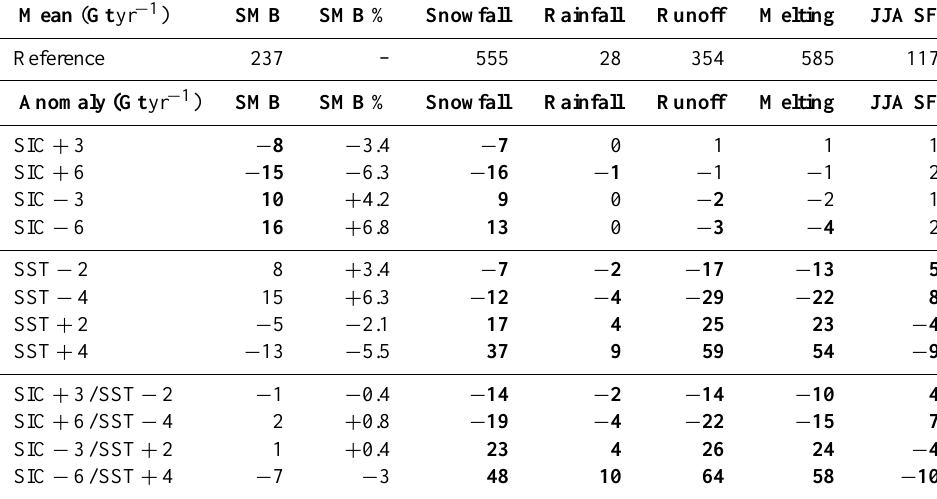
Table 2. Top: annual mean cumulated GrIS SMB (Gtyr − 1 ) and its components (Gtyr − 1 ) for the reference run (2007–2012). Bottom: difference in SMB (Gtyr − 1 and %) and its components (Gtyr − 1 ) between each sensitivity experiment and the reference run over 2007– 2012. The last column lists JJA mean cumulated snowfall (Gt/JJA) over the GrIS for the reference run (top) and the anomalies (Gt/JJA) induced by each sensitivity experiment (bottom). Significant anomalies are displayed in bold for each